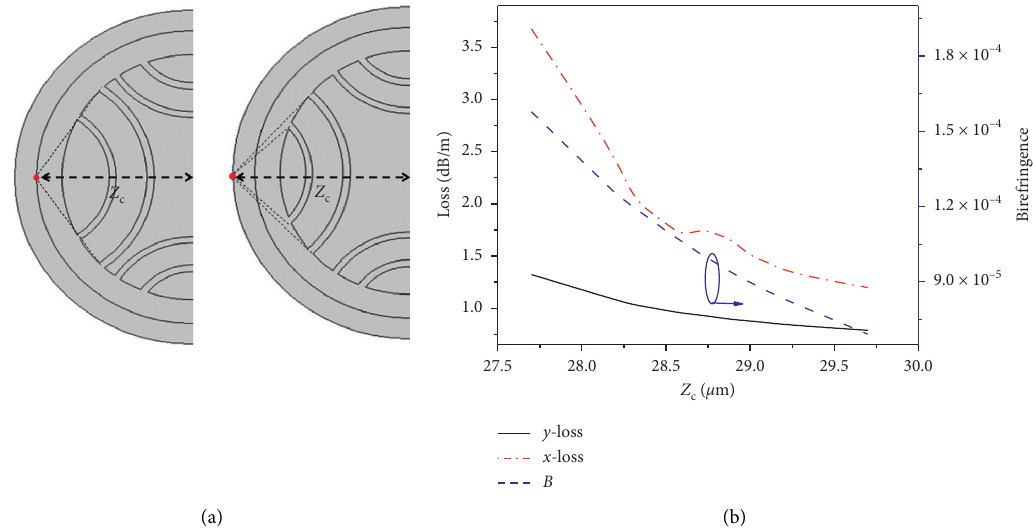
Figure 7: (a) The change of Z c with a fixed radius; (b) fixing radius, x and y polarization mode loss and birefringence as a function of Z c